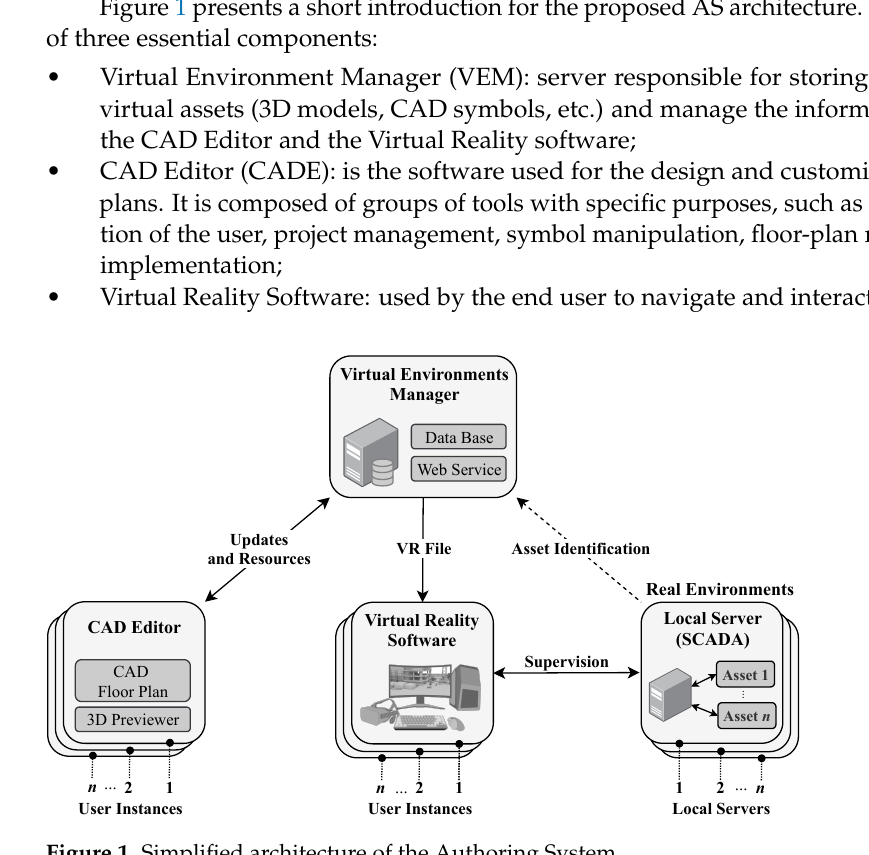
Figure 1. Simplified architecture of the Authoring